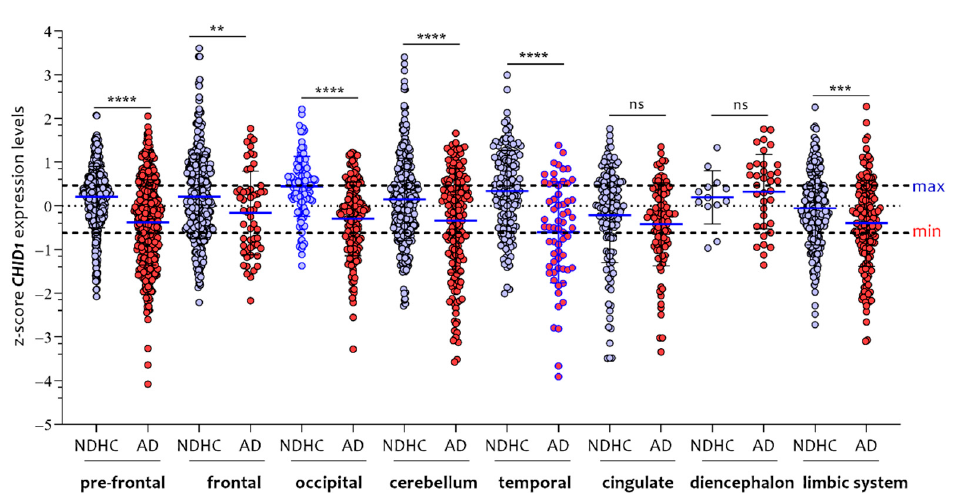
Figure 7. CHID1 expression levels comparative analysis in eight brain regions of NDHC subjects and AD patients. By analyzing the individual brain regions according to the disease, we observed that the CHID1 expression levels were significantly higher in NDHC than in AD in all brain regions, with the exception of the diencephalon and cingulate regions. Data in the figure are indicated as z-score intensity expression levels and presented graphically as violin dot plots. p values < 0.05 were considered to be statistically significant (ns = not significant; ** p < 0.001; *** p < 0.0001; **** p < 0.00001).